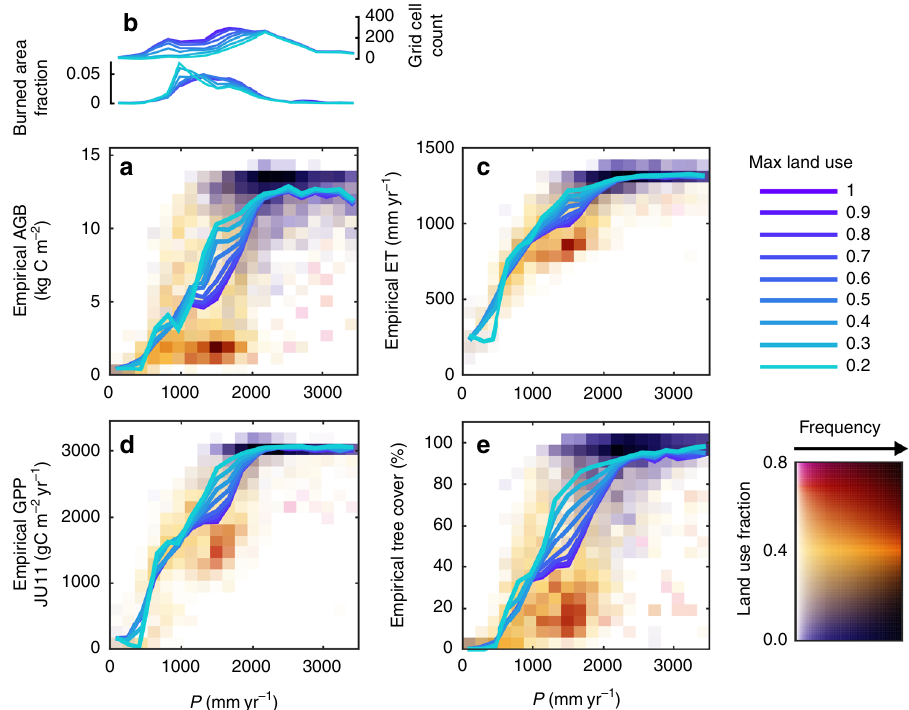
Fig. 4 Functional relationships and their dependency on land use. a Dependency of above ground biomass (AGB) on precipitation ( P ). Coloured frequency fi eld shows the dependency of AGB on P and land use. Colour follows the mean land use fraction in a P-AGB bin, and the saturation describes relative frequency. Coloured lines represent the functional relationships, found when averaging AGB over P-bins. The colours describe the maximum land use fraction of the grid cells included in the calculations of the functional relationships; from all grid cells (1) to only include grid cells with land use fraction lower than 0.2. This procedure was repeated for burned area fraction which is shown in b together with the number of grid cells available per land use limit. c through e show the corresponding frequency fi elds and functional relationships of evapotranspiration (ET) c , gross primary productivity (GPP) d and tree cover e . For ET c the spatial distribution of mean ET and P were calculated from the three data sets before the analysis of the functional relationships, where P differ only in the time period used for the climatology (individual panels for the three ET data sets are shown in Supplementary Fig.